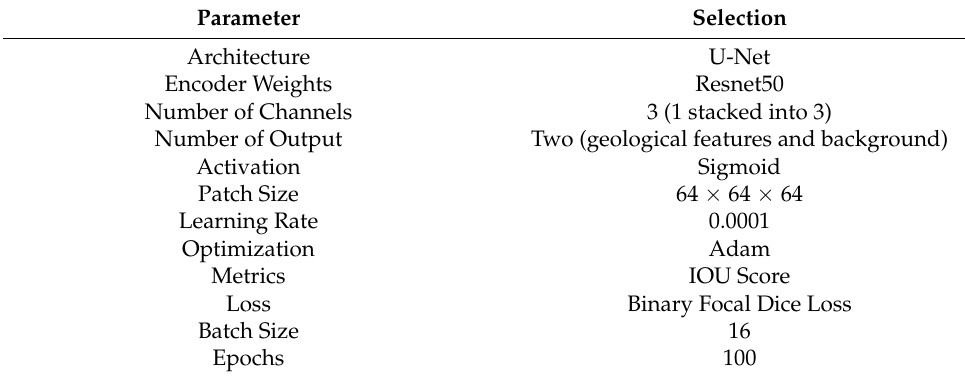
Table 2. Selected hyperparameters. Parameter